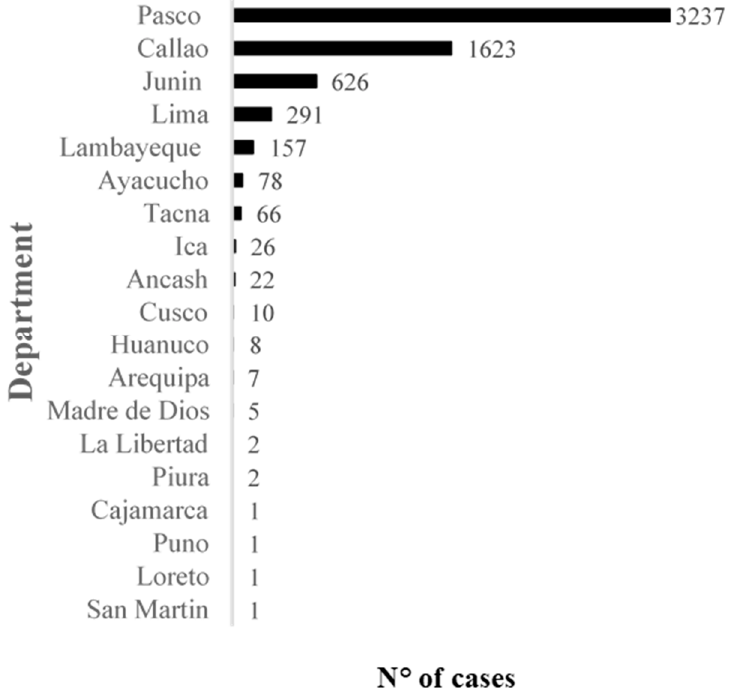
Figure 2. Number of acute heavy-metal-related intoxications in Peru in 2018. Data adapted from a report by the Ministry of Health (MINSA, 2019b).